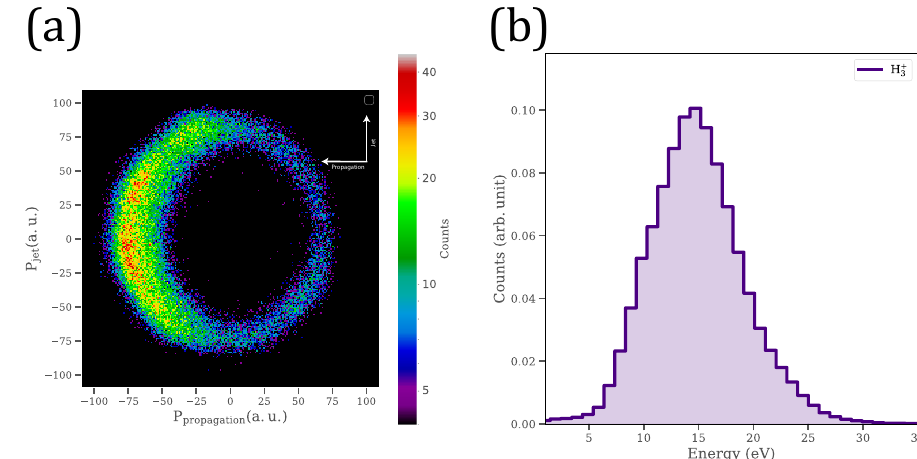
Fig. 3 Momentum and energy of H þ . a 2D momentum image demonstrating the angular distribution in the plane of laser propagation vs. nanoparticles jet 3 where the laser polarization is perpendicular to this plane and b energy distribution of H þ emitted from the surface of 300 nm silica nanoparticles inhabited 3 by H 2 O molecules at a laser intensity of 2 × 10 14 W/cm 2 . Source data are provided as a Source Data fi